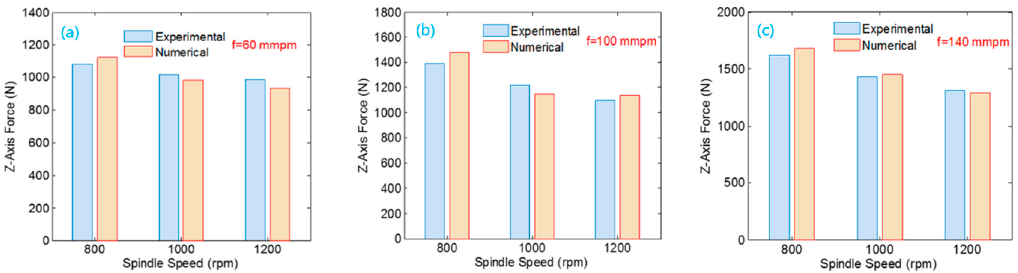
Figure 8. Data comparison for different feed speeds: ( a ) feed speed is 60 mm/min; ( b ) feed speed is 100 mm/min; and ( c ) feed speed is 140 mm/min.